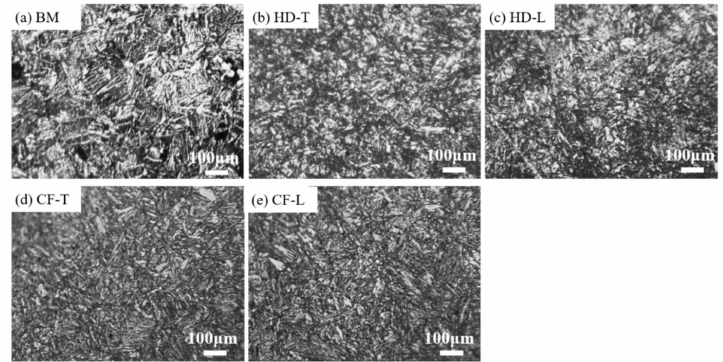
Figure 8. Microstructures for ( a ) BM, ( b ) HDT, ( c ) HDL, ( d ) CFT, and ( e ) CFL.